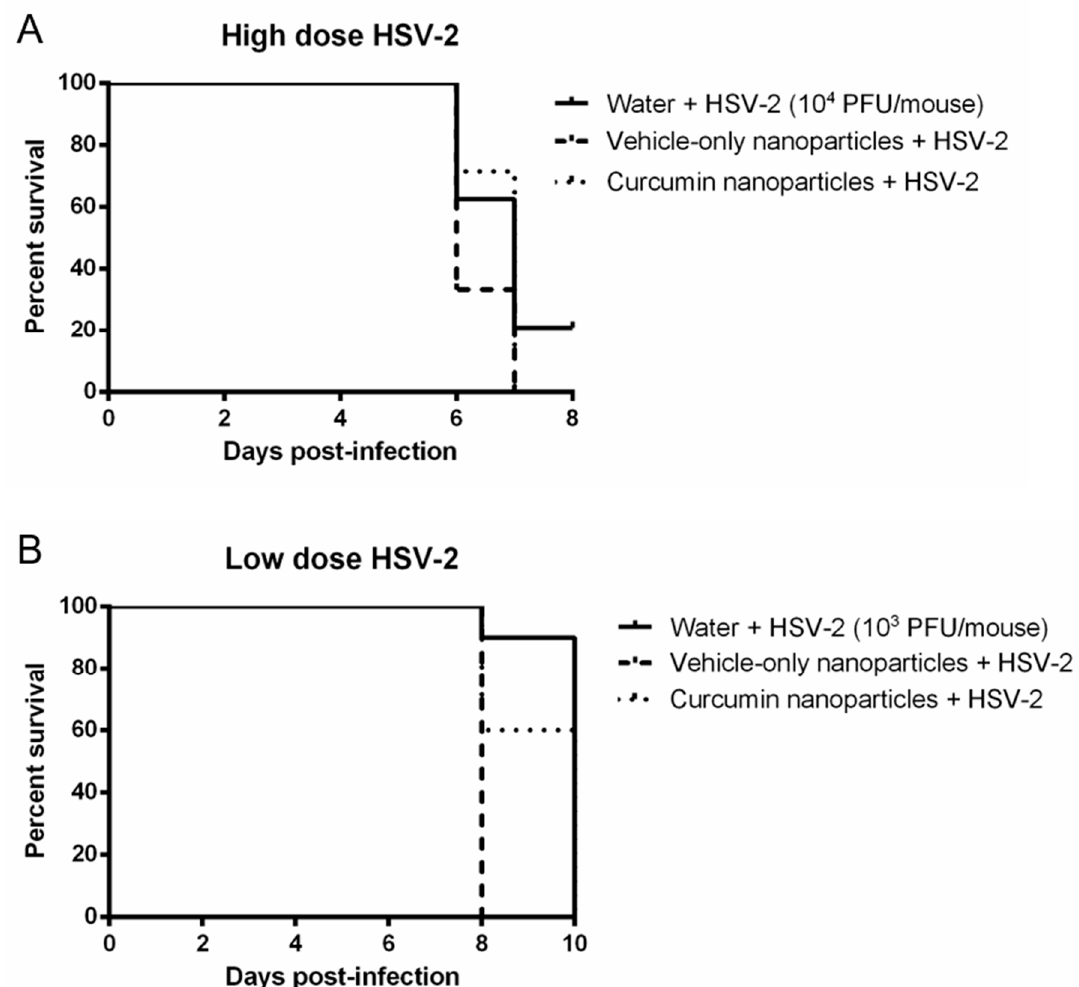
Figure 5. Survival of mice in response to high- and low-dose Herpes Simplex Virus Type 2 (HSV-2) infection when treated with curcumin nanoparticles. Depo-treated mice ( n = 5–10 per group) received either water, 0.5 mg vehicle-only nanoparticles or 0.5 mg curcumin in nanoparticles IVAG, 2 h prior to inoculation with HSV-2 at ( A ) high dose (10 4 PFU / mouse) or ( B ) low dose (10 3 PFU / mouse). Survival was monitored for 8–10 days post-infection and is displayed as % survival per day post- infection.